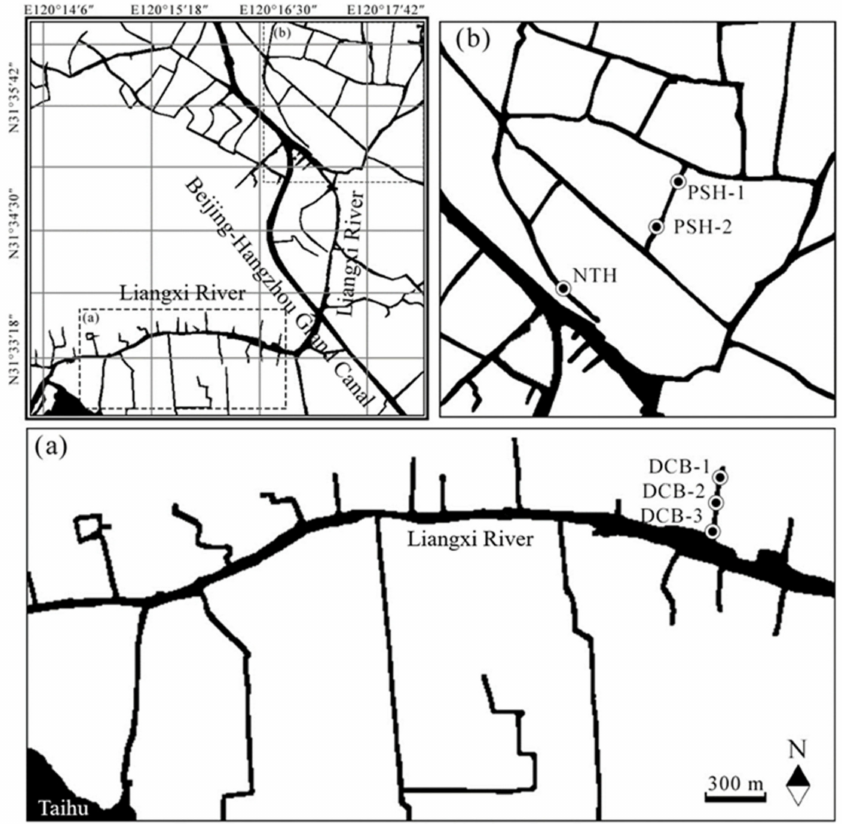
Figure 1. The distribution of sampling sites: ( a ) the distribution of DCB sampling sites; ( b ) the distribution of PSH and NTH sampling